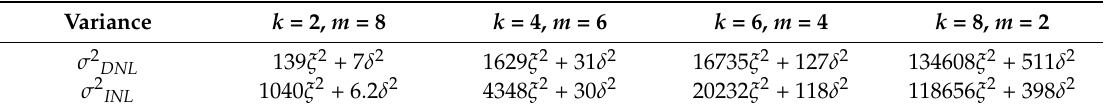
Table 1. The quantity comparison of theoretical variance of DNL and INL for different sets of k and m for a 10-bit R-I